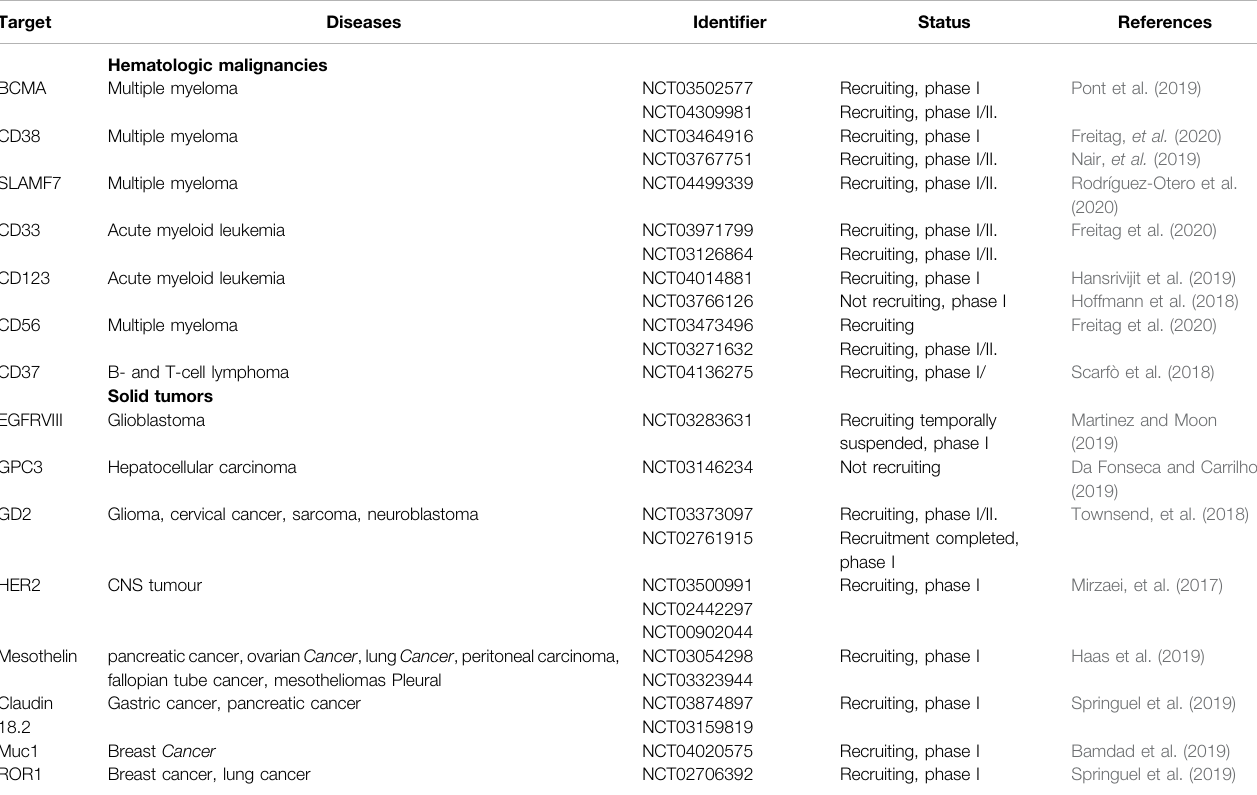
TABLE 3 | Novel targets for hematologic malignancies and solid